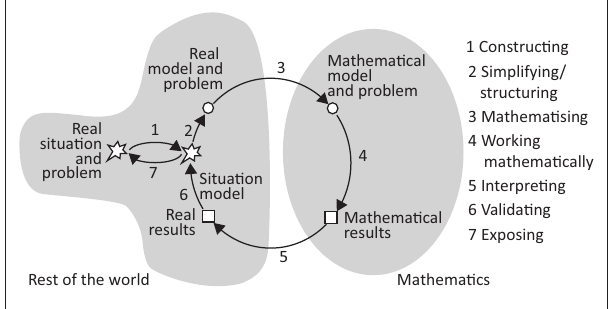
FIGURE 1 : The modelling cycle according to Blum and Leiß